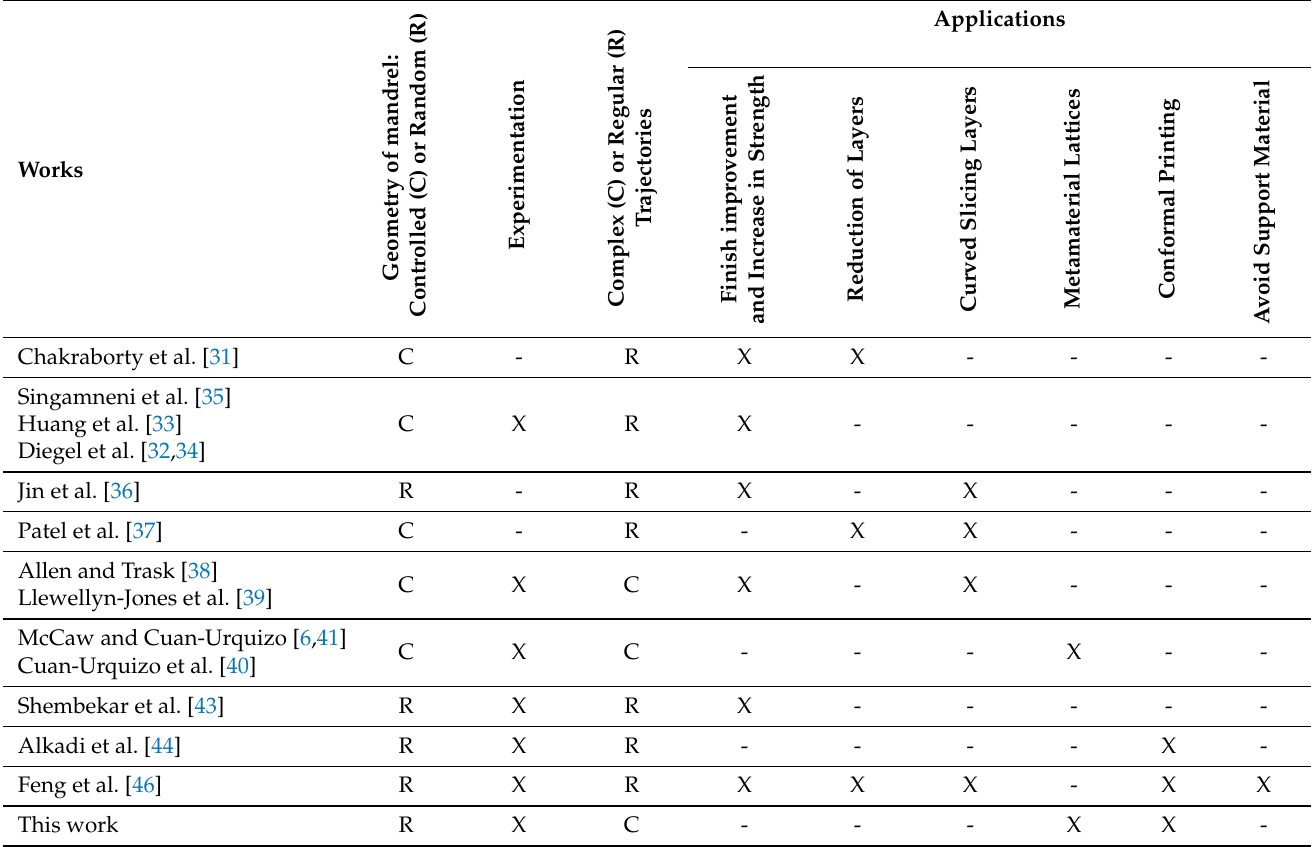
Table 1. Comparison of important aspects of reviewed authors to highlight this work contribution. A controlled mandrel means that it is mathematically parametrized. A random mandrel means that its shape is not mathematically defined. A regular trajectory is that which is usually used, e.g., zigzag or circular. Complex trajectories are those that involve periodic or fractal patterns.